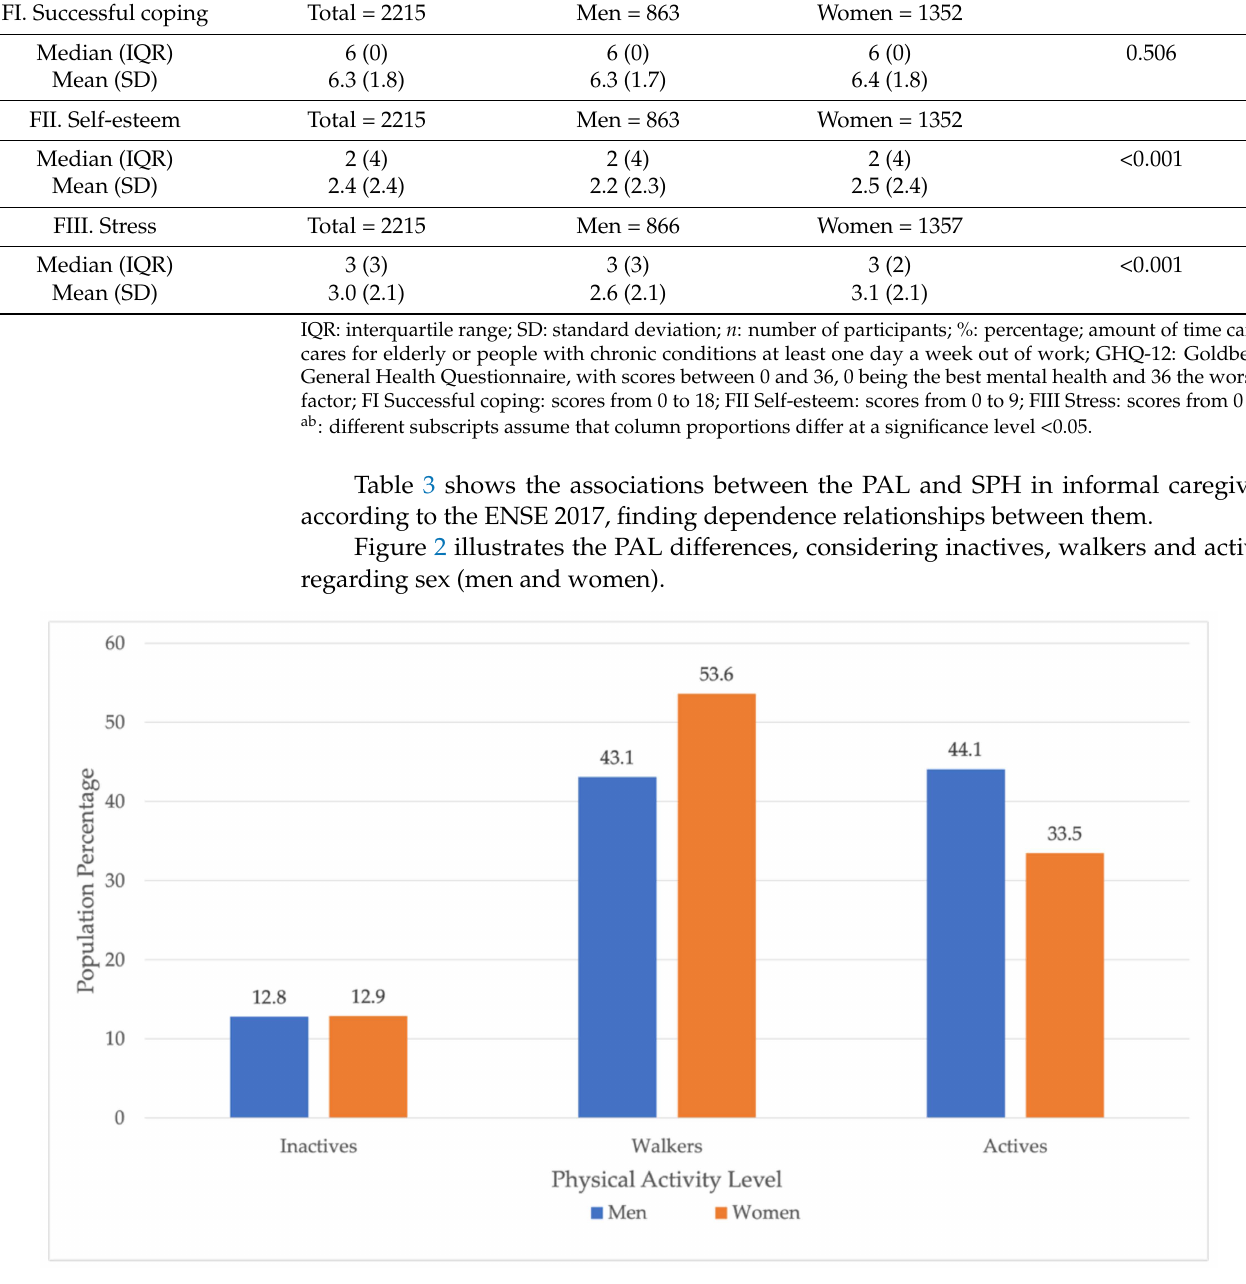
Figure 2. Comparison of physical activity level by sex (men and